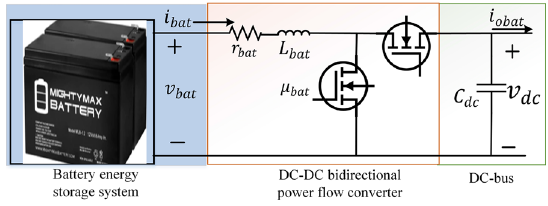
Fig. 5 The equivalent circuit diagram of the BESS with a